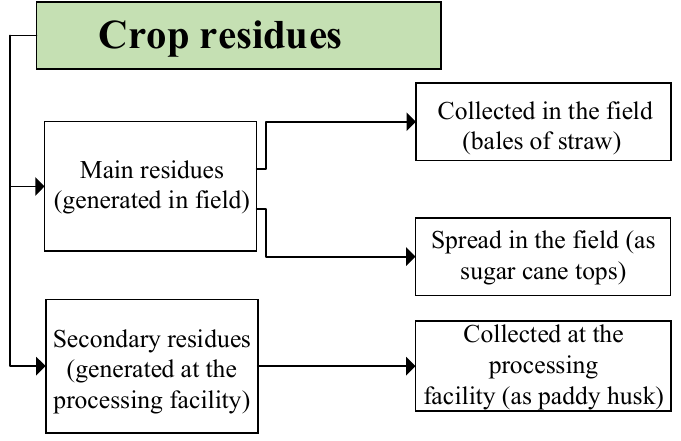
Figure 7. Crop-residue classification.